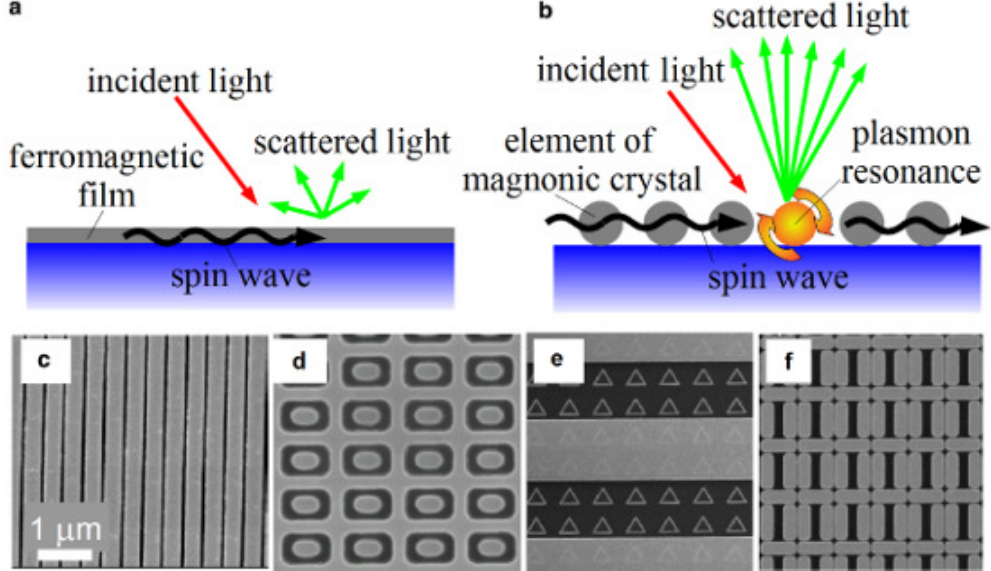
( a ) Light interaction with a spin wave in a uniform ferromagnetic thin film sitting on top of a dielectric substrate; ( b ) Excitation of the plasmon resonance in a ferromagnetic magnonic crystal leads to enhancement of the intensity of light scattered from the spin wave; ( c–f ) Some examples of plasmon resonance-supporting Permalloy